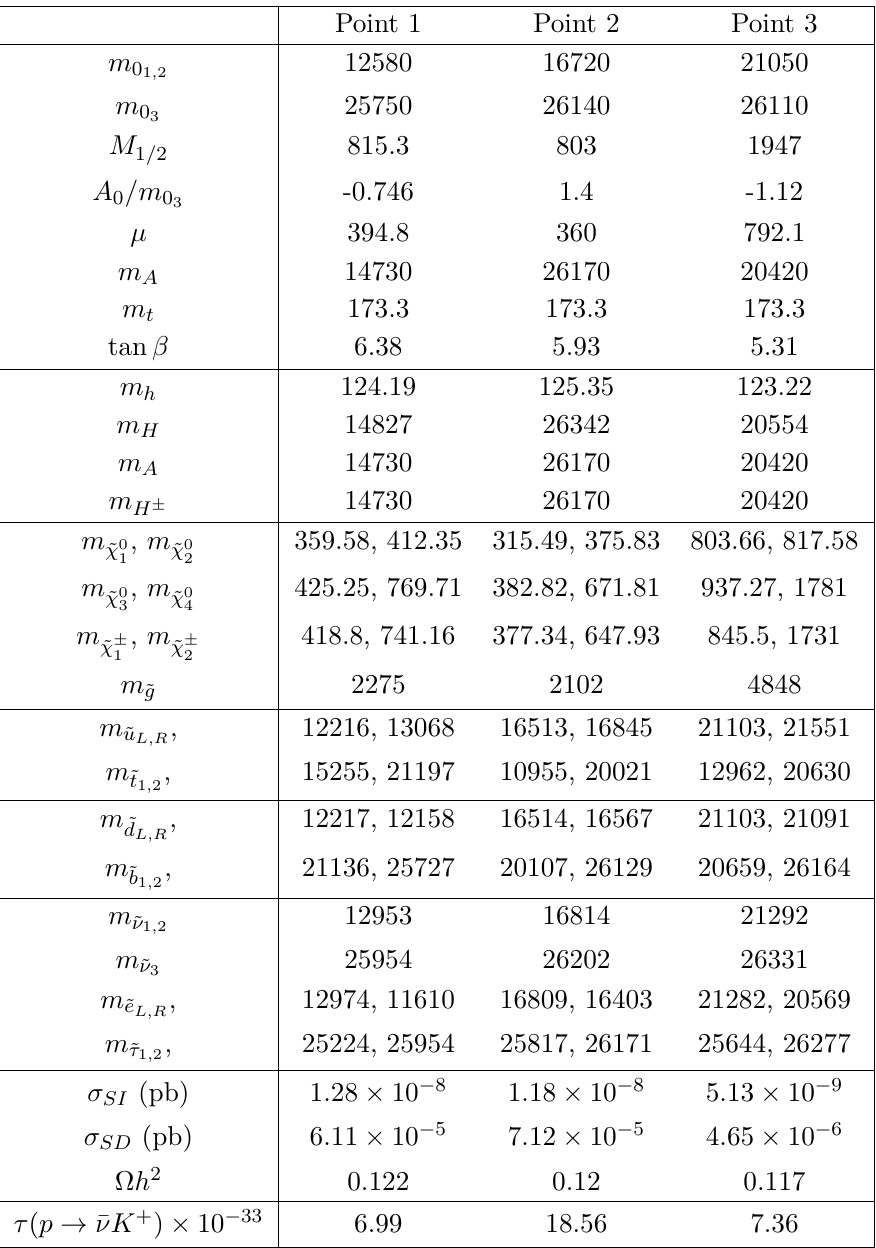
Table 1 . A table of three benchmark points satisfying the mass bounds, B-physics constraints and the Proton lifetime measurements. All the masses are in units of GeV, and the proton lifetime is given in years. Points 1 displays the lowest value for m 0 when solutions are allowed by the Planck 1 , 2 bound within 5 σ . Point 2 shows a solution for the lightest Higgsino mass consistent with the Planck bound. Point 3 represents solutions with relatively lower spin-independent and spin-dependent scattering cross-sections of